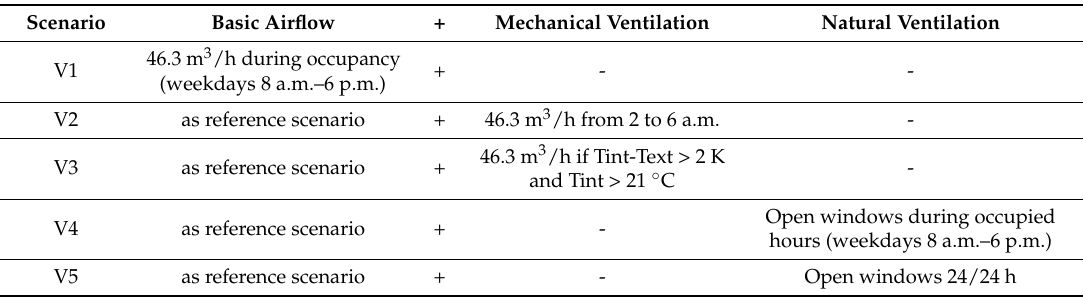
Table 3. Ventilation scenarios used for the